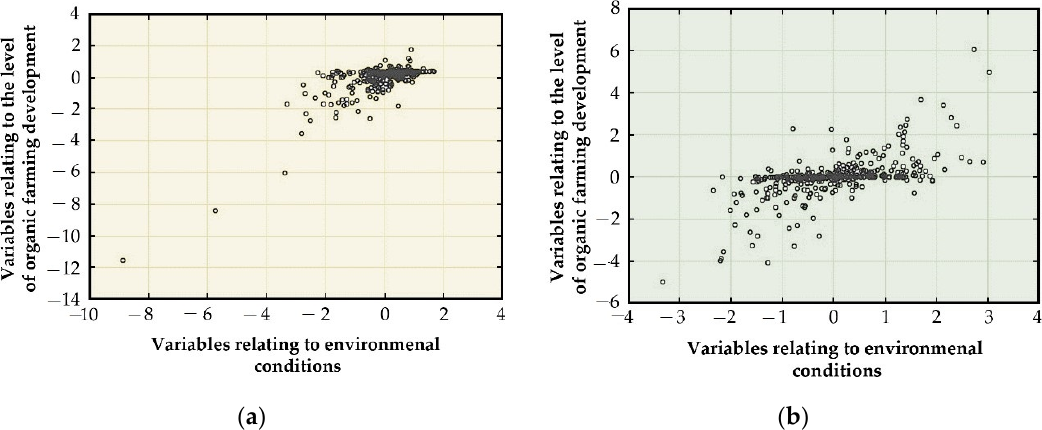
Figure 2. Scatter plots for the statistically significant canonical variables; ( a ) First canonical root; ( b ) Second canonical root.